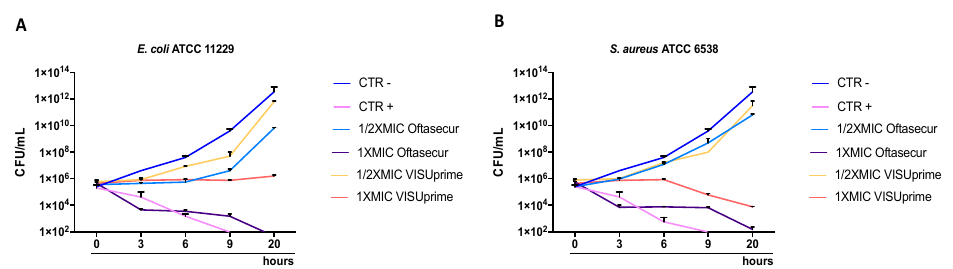
Figure 5. Oftasecur and Visuprime killing kinetics on ( A ) E. coli and ( B ) S. aureus .